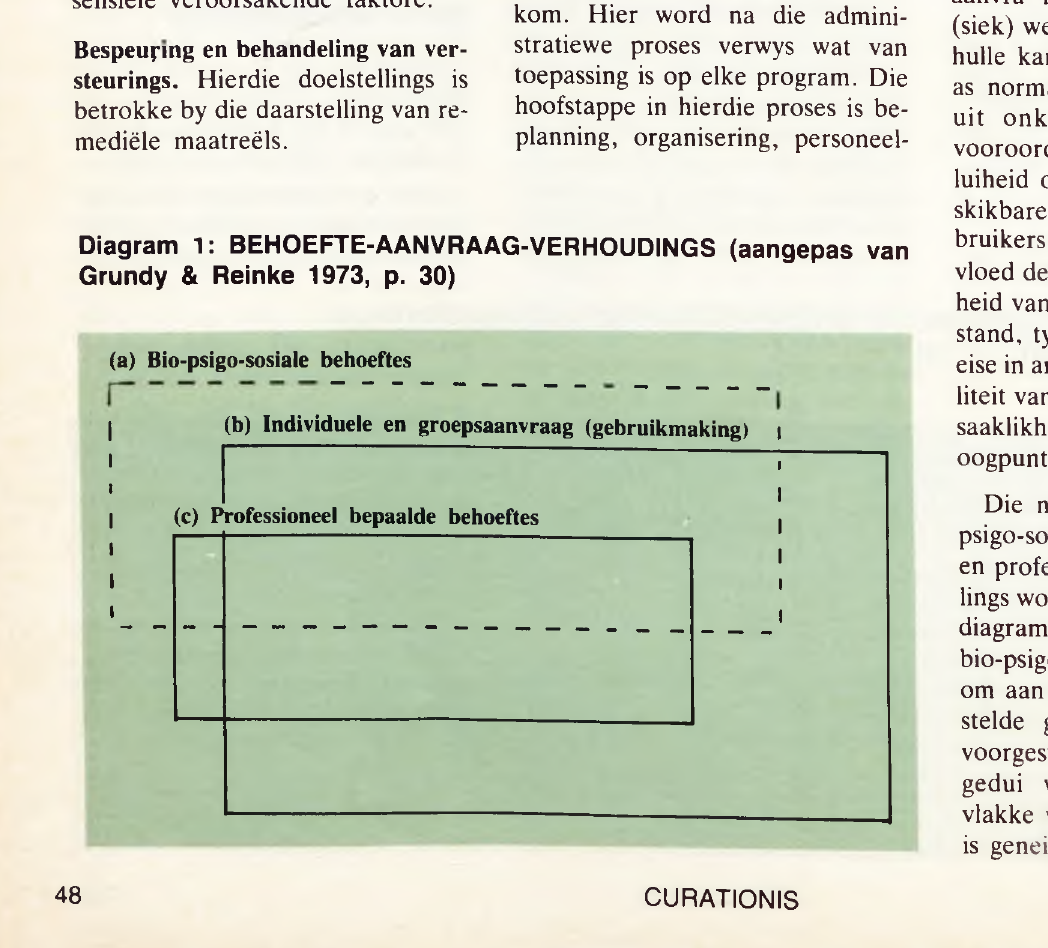
Diagram 1: BEHOEFTE-AANVRAAG-VERHOUDINGS (aangepas van Grundy & Reinke 1973, p.